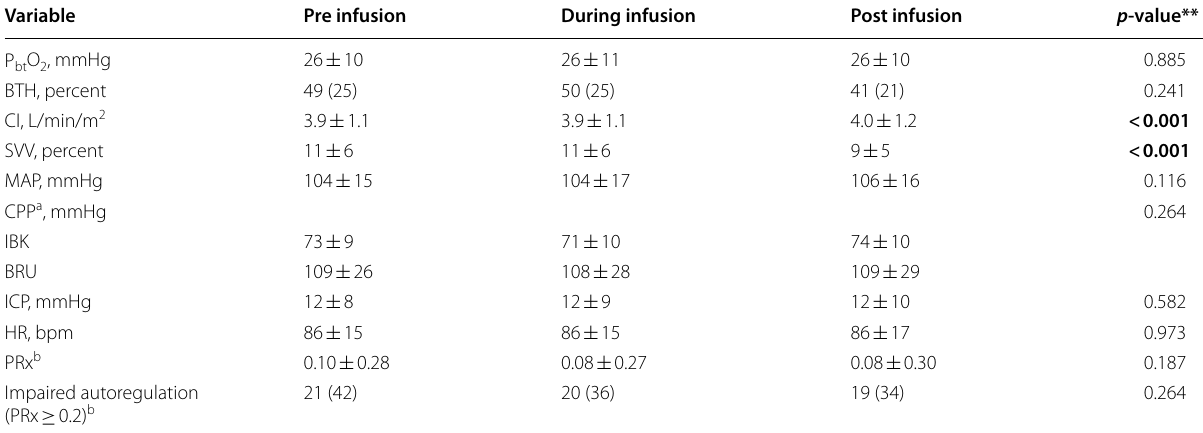
Table 2 Changes of variables pre‑, during, and post‑fluid administration in a total of 198 infusions in 48